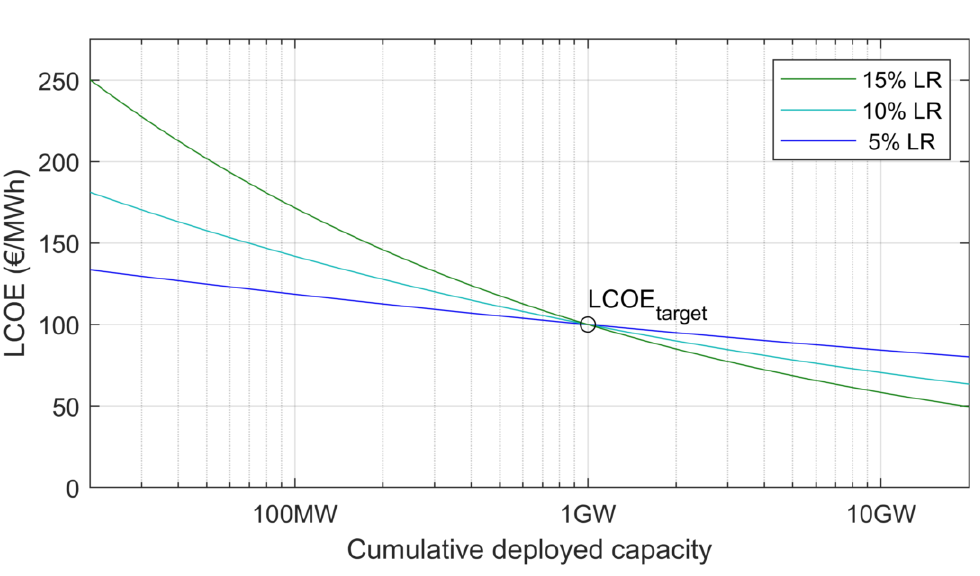
Figure 2. Example single-factor experience curves for three different learning rates. The curves show the LCOE value when consistent learning starts depending on the learning rate, if the LCOE target value of 100 €/MWh is achieved after 1 GW.